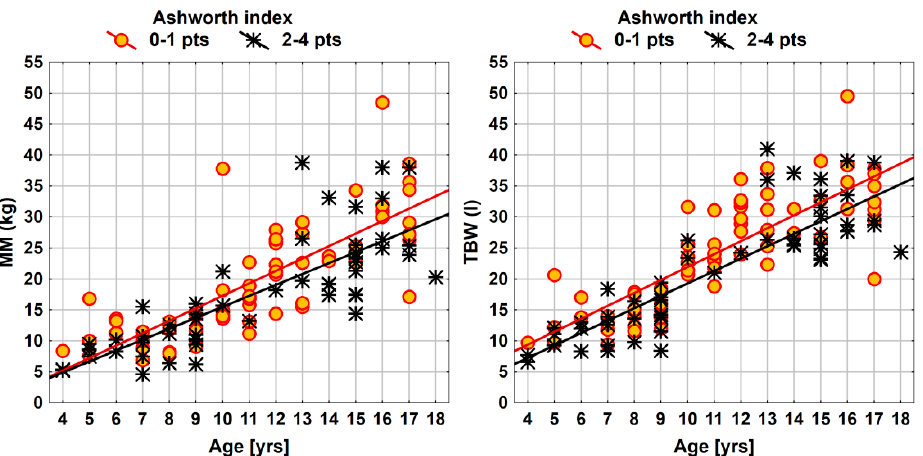
Figure 1. Effects of muscle tone in muscle mass and total body water in the children with CP. Abbreviations: MM - muscle mass; effect of muscle tone in body composition of children with CP shown using